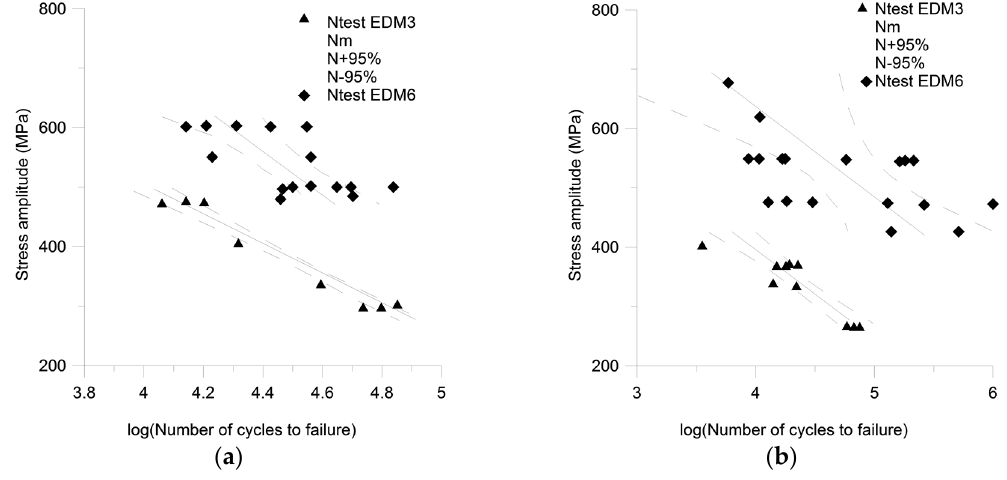
Figure 14. Fatigue life under different conditions ( a ) CALMAX(CLX) ( b )ASP2023(A23) [25].